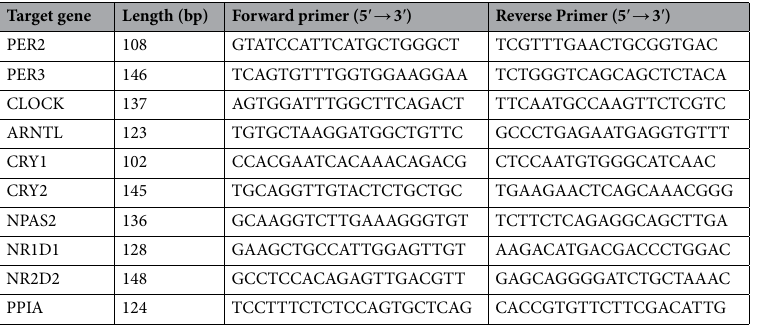
Table 1. List of target specific primer sequences for real time RT-qPCR analysis used in this circadian